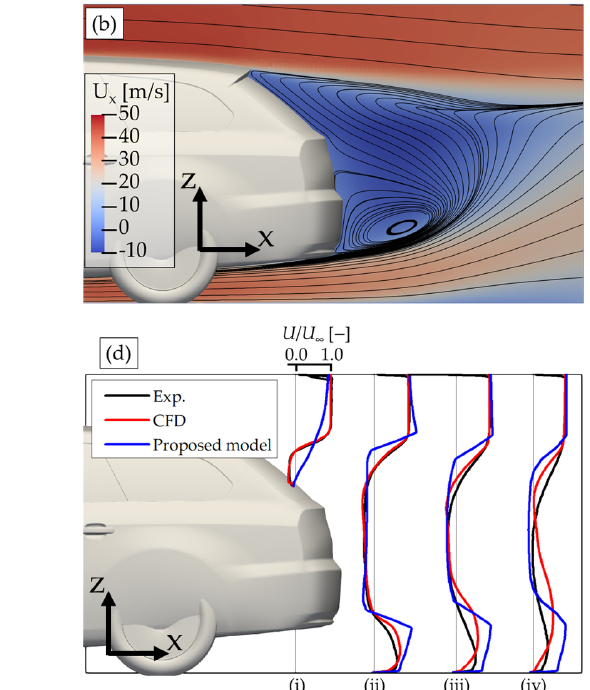
Figure 9. Streamlines and velocity profile in the near-wake region of the estateback vehicle, along the centerline of the y -direction, in the x - z plane. ( a ) Experiment [8], ( b ) CFD model, ( c ) Proposed model ( d ) comparisons of the velocity profiles. Velocity profiles are drawn from the front of the vehicle at downstream positions of ( i ) 1089 mm, ( ii ) 1199 mm, ( iii ) 1314 mm, and ( iv ) 1422